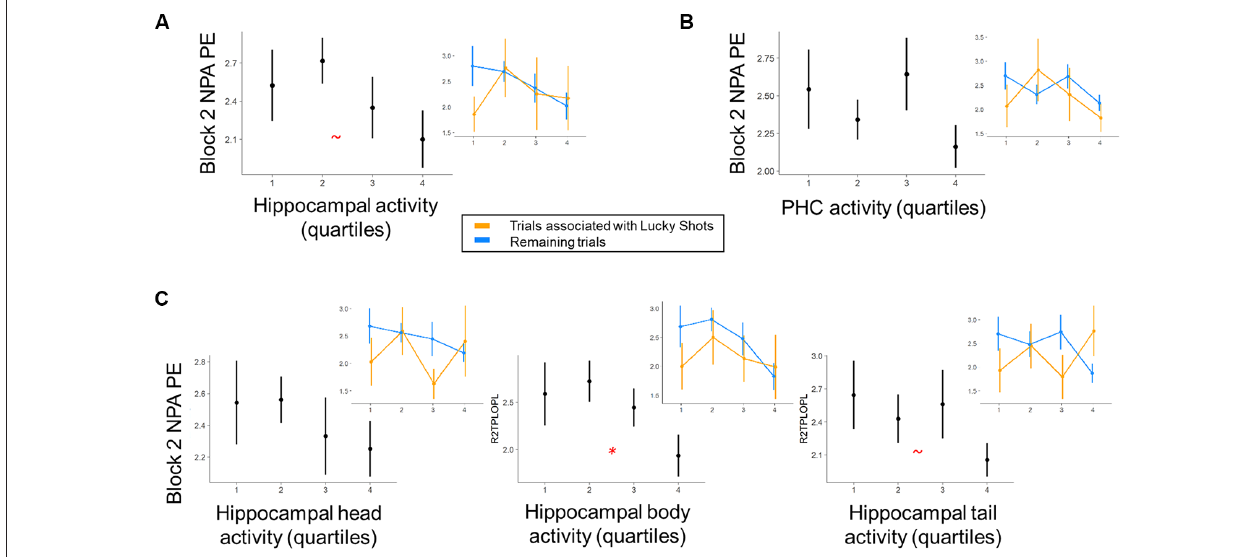
FIGURE 4 | Within-subject trial-level relationship between region of interest (ROI) activity and NPA performance after one-shot learning. Quartiles reflect within-subject binning of environment-by-environment measures into quartiles for visualization purposes only (Linear Mixed Effects, LME analyses used continuous performance differences across each environment). (A) During NPA block 2 prospective planning (i.e., after one-shot learning), there was a marginal relationship between hippocampal activity and navigation performance. (B) This relationship was non-significant in parahippocampal cortex. (C) Within hippocampal